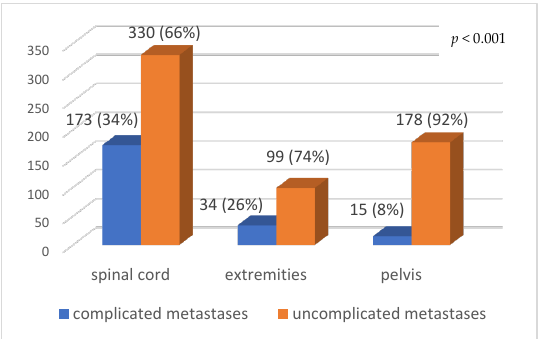
Figure 2. Complications according to the site of metastases.